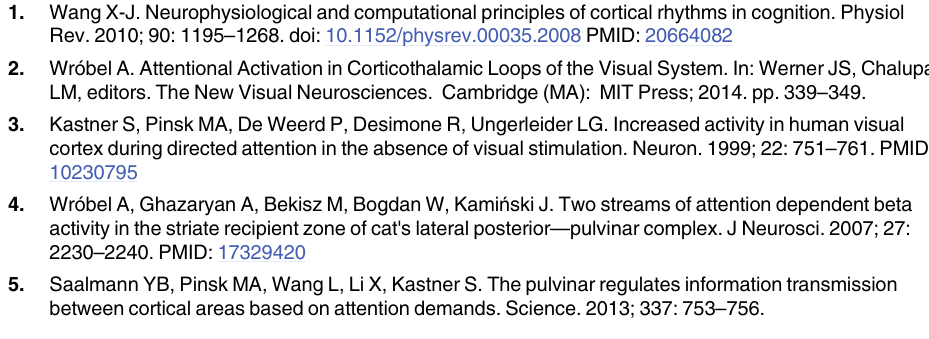
S5 Fig. Synchronization of beta signals for individual pairs of electrodes. Each data point (square) represents the visual (ordinate) and auditory (abscissa) correlation between the beta signals recorded from a single pair of electrodes. For the entire group of electrode pairs, the visual and auditory correlation values related well with each other during the stimulus-driven task (red squares; Pearson r = 0.972, P < 0.001, n = 20, 95% confidence interval 0.928 to 0.989), and this relationship was almost perfectly linear during the anticipatory task (blue squares; Pearson r = 0.996, P < 0.001, n = 61, 95% confidence interval 0.993 to 0.998), with the regres- sion line Y = 0.994 (cid:3) X + 0.001 (with respective 95% confidence intervals: 0.971 to 1.017 and -0.014 to 0.015) that was not different from the diagonal. However, 75% of the data points for the stimulus-driven task are located below the diagonal, leading to a steeper regression line Y = 1.223 (cid:3) X − 0.233 (respective 95% confidence intervals: 1.075 to 1.371 and -0.3421 to -0.1241), with a positive X intercept of 0.191 (95% confidence intervals: 0.115 to 0.251). S6 Fig. Correlation during incorrect visual trials in stimulus-driven paradigm. The graph shows differences between correlations from incorrect visual trials and correlations from cor- rect auditory trials (ordinate) plotted against the respective correlation values from incorrect visual trials (abscissa). No relation between both variables was detected (r = -0.21, P = 0.38, n = 20). Red circles — both recording sites in area 17; blue — both sites in area 18; green — one site in area 17, other in area 18. Due to the fact that the same moving visual stimulus was pres- ent during correct and incorrect visual trials, this analysis confirms that the correlation pattern observed for correct trials (S4C Fig) was caused mainly by the attentional processes and not by the presence of the